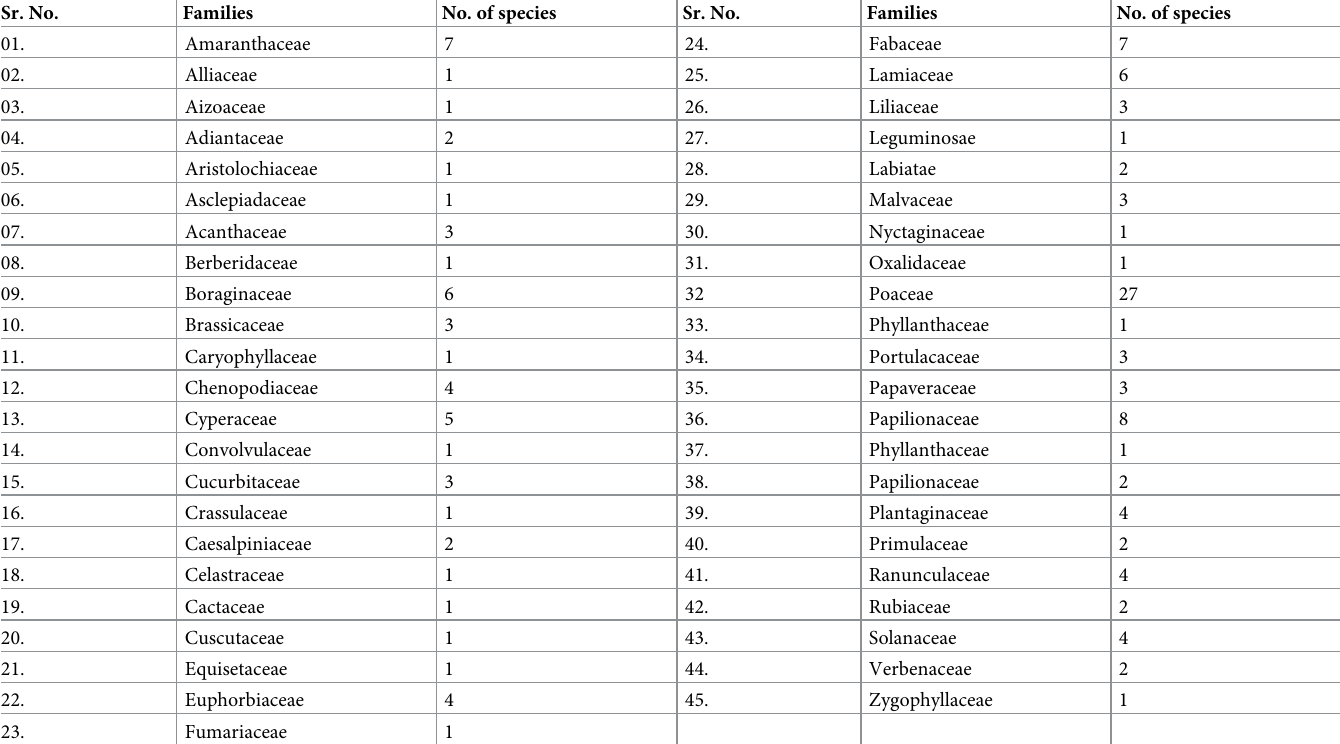
Table 1. Family index of herbal flora of District Bhimber of AJK Pakistan. Sr. No.